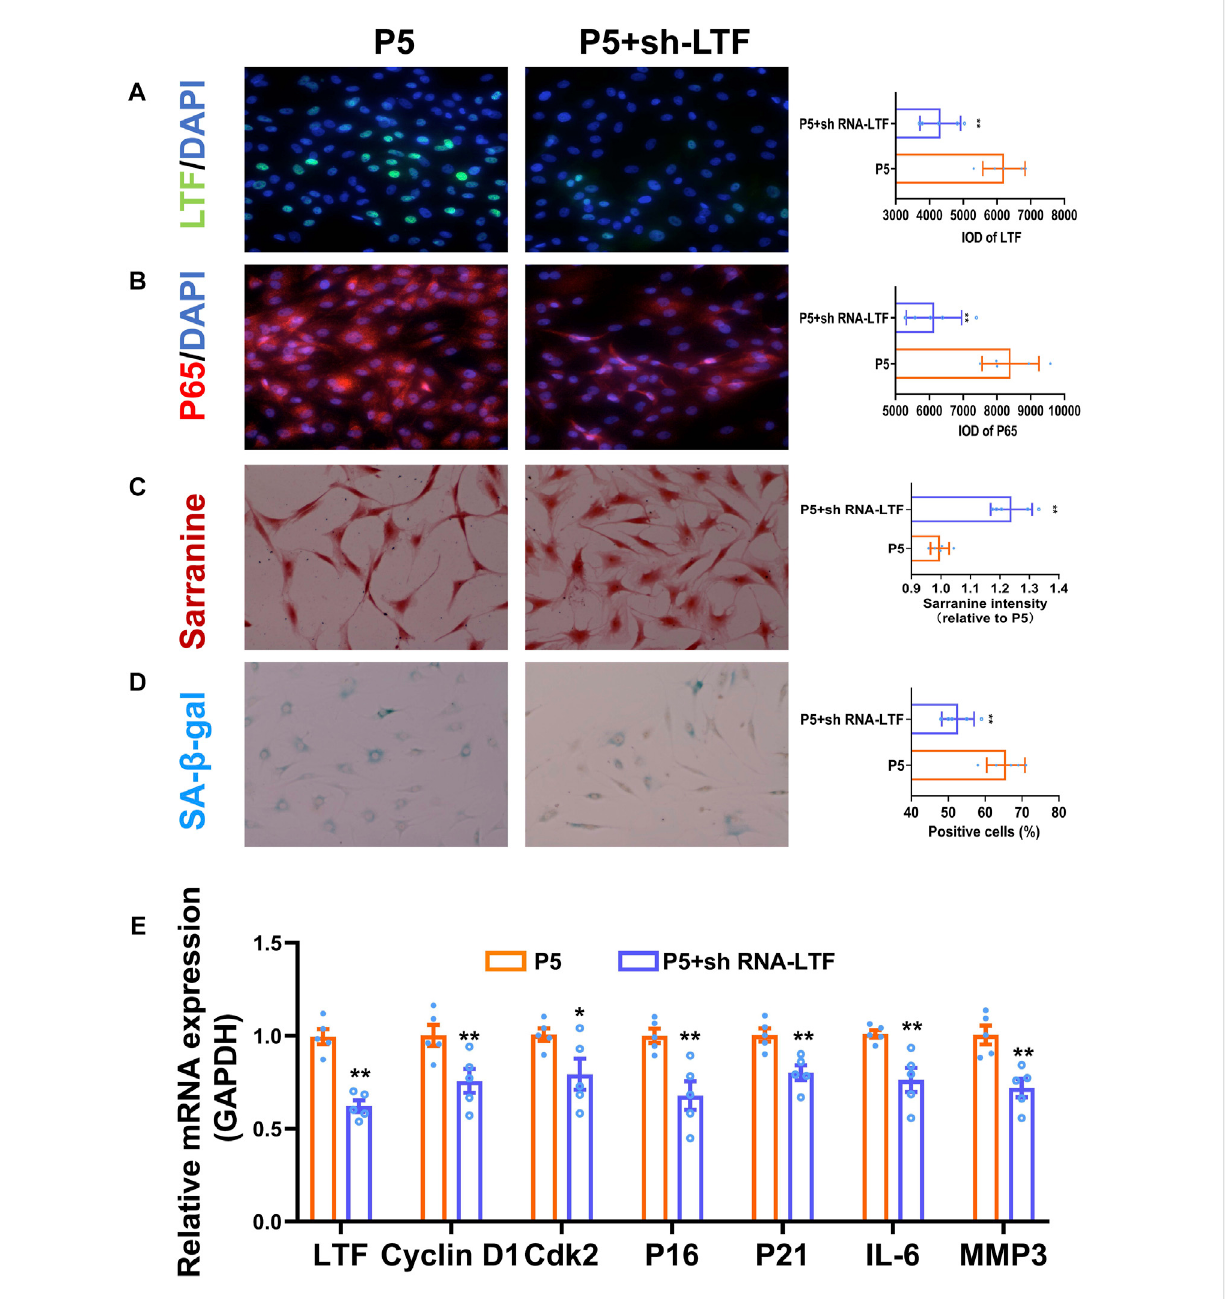
FIGURE 6 KnockdownofLTFinhibitedtheNF- κ Bsignalingpathwayandalleviatedmeniscalsenescence. (A,B) Representativeimagesandquantitativeanalysis ofimmuno fl uorescenceforLTFandP65,scalebar=50 μ m. (C) RepresentativeimagesandquantitativeanalysisofSafranin-Ostaining,scalebar=50 μ m. (D) Representative images and quanti fi cation of SA- β -Gal positive cells of SA- β -Gal staining cells, scale bar = 50 μ m. (E) The mRNA expression of LTF, CyclinD1,Cdk2,P16,P21,IL-6andMMP3.Mean±S.E.M.,* p < 0.05,** p < 0.01comparedwithcontrolgroups,n=5.LTF,lactotransferrin;P65,RELA proto-oncogene, NF- κ B subunit; SA- β -Gal, senescence-associated β -galactosidase; P16 (CDKN2A), Cdk2, cyclin dependent kinase 2; cyclin dependent kinase inhibitor 2A; P21 (CDKN1A), cyclin dependent kinase inhibitor 1A; IL-6, interleukin 6; MMP3, matrix metallopeptidase